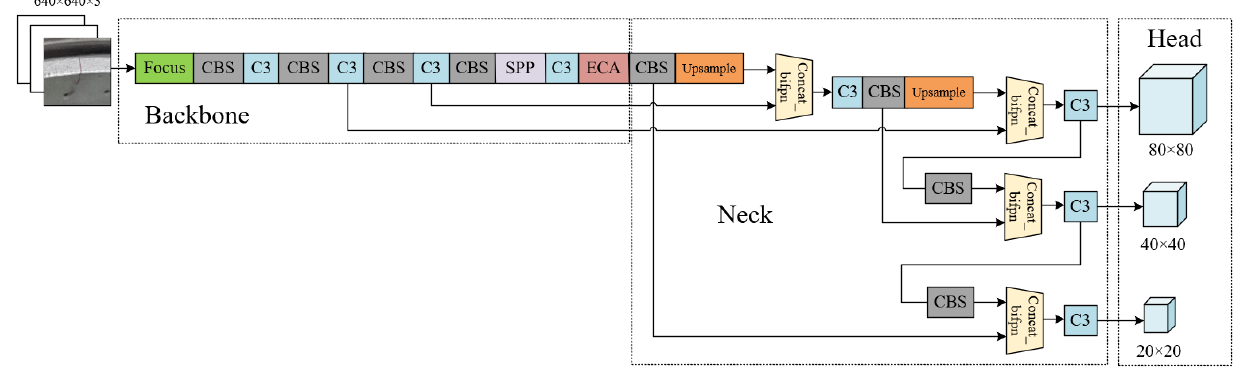
Figure 4. The architecture of the YOLOv5s-KEB model.